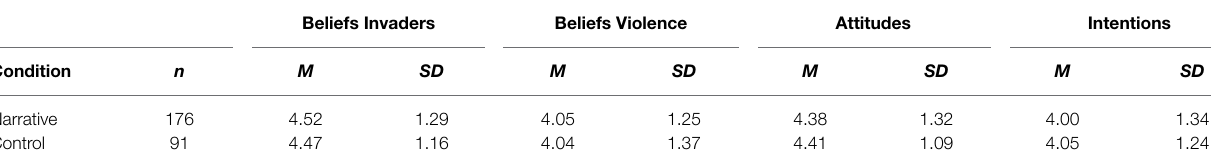
TABLE 2 | Properties of study outcomes by narrative condition.